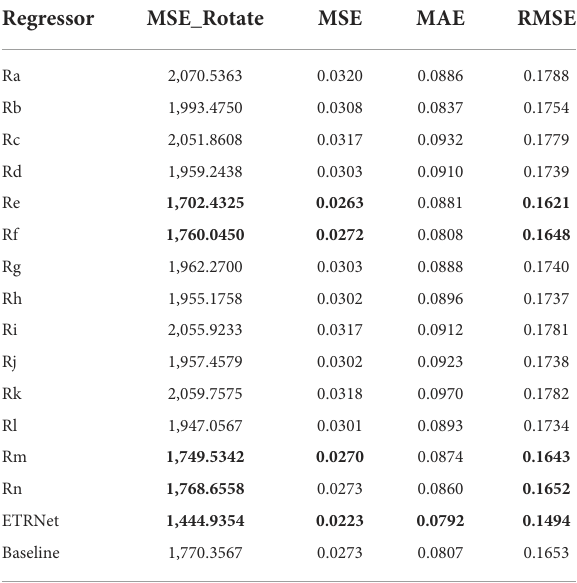
TABLE 2 Comparison of MSE_Rotate, MSE, MAE, RMSE on